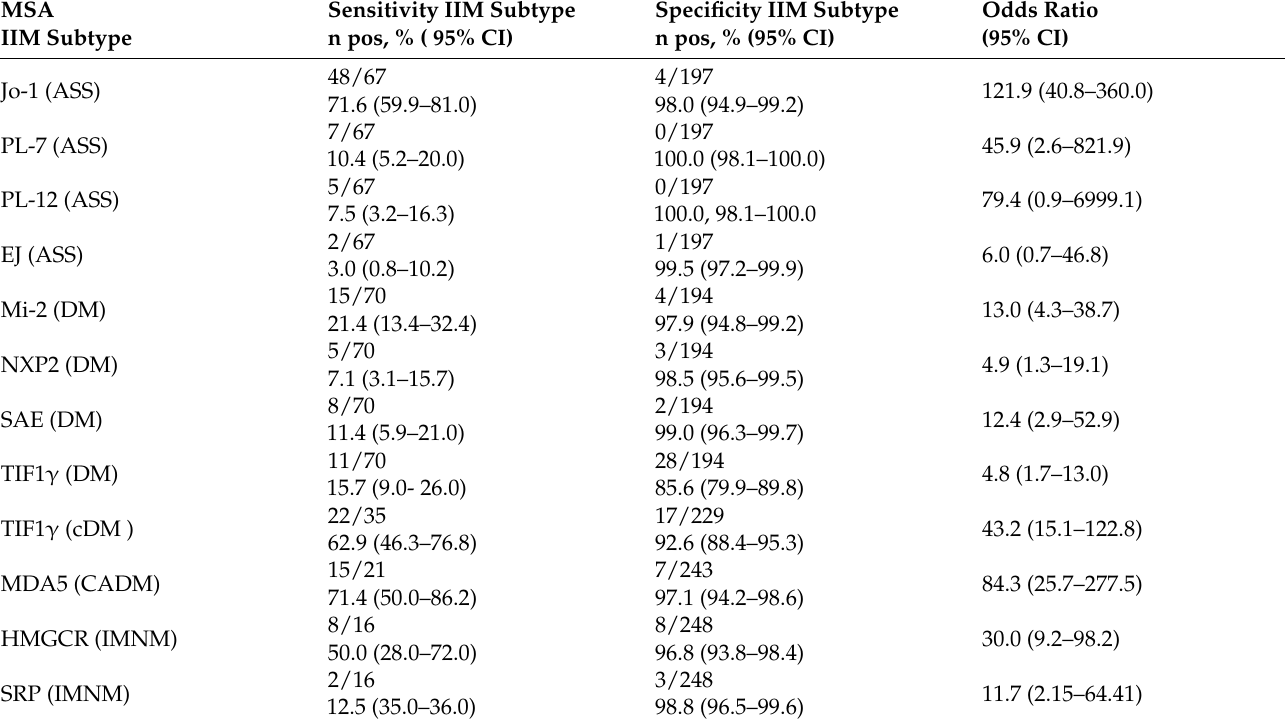
Table 2. Prevalence of autoantibodies in myositis